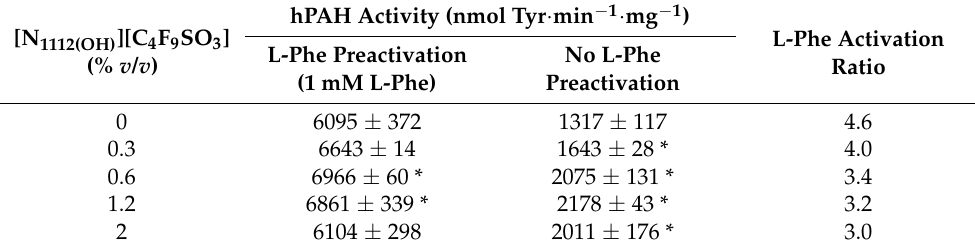
Table 1. Catalytic activity of non-activated and preactivated hPAH in the absence and presence of increasing concentrations of [N 1112(OH) ][C 4 F 9 SO 3 ]. Data are shown as mean ± SD of triplicate assays. (*) Significant statistical